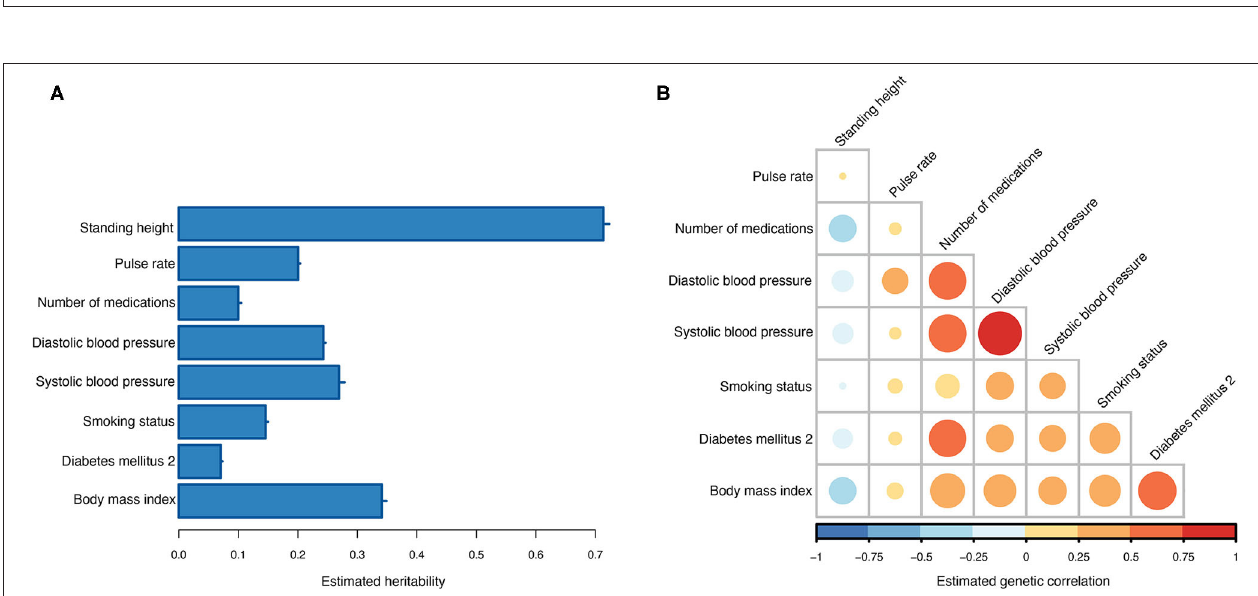
FIGURE 3 | Estimated genetic parameters. (A) Estimated heritabilities for T2DM and the seven information traits. Errors bars indicate the standard error of the estimates across the 10 training sets. (B) Estimated genetic correlations between T2DM and the seven information traits.